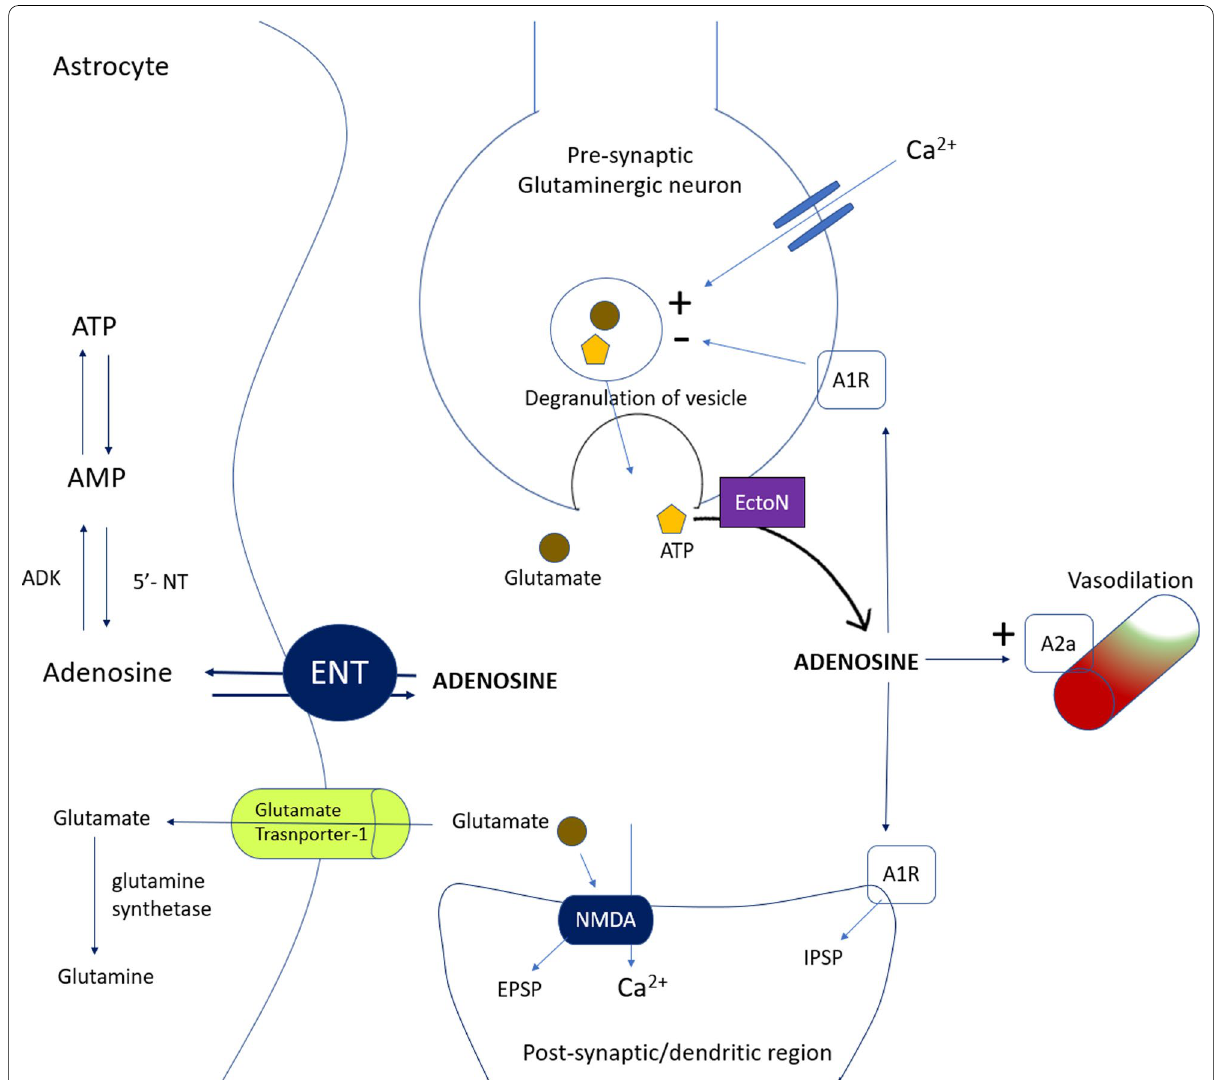
Fig. 3 Interaction of adenosine with its receptor in astrocytes and blood